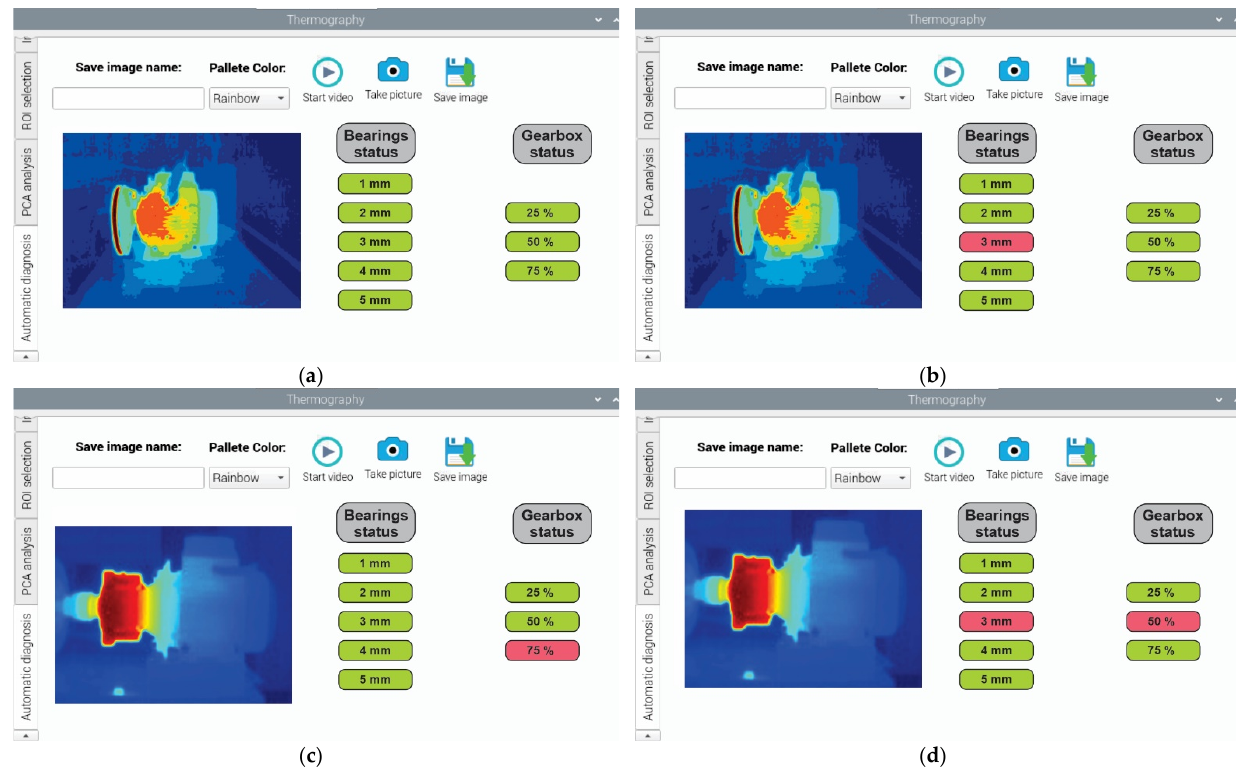
Figure 16. Results observed in the tab “Automatic diagnosis” for the rolling bearings and the gearbox of the induction motor, in ( a ) healthy conditions, in ( b ) outer-race fault with severity of 3 mm, in ( c ) gear wear with severity backlash of 75%, and in ( d ) combined fault as outer-race fault and gear wear with severities of 3 mm and backlash of 50%, respectively.